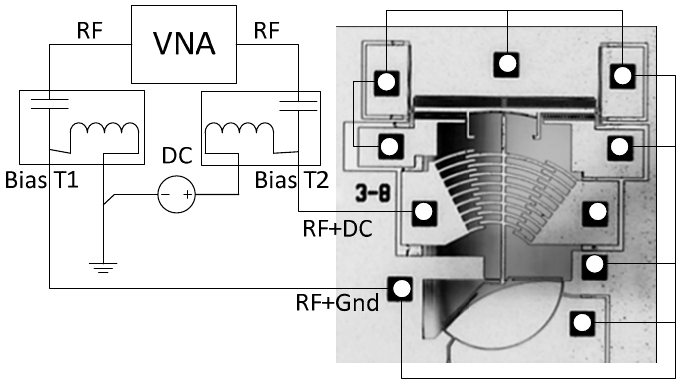
Figure 4. Test setup for the rotational actuation of the platform.